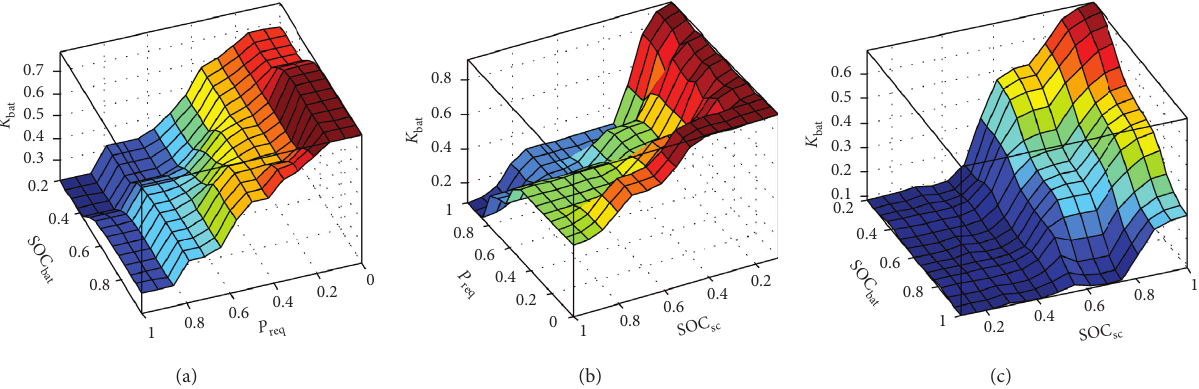
Figure 6: (a, b) Relation of inputs and output in discharge. (c) Relation of inputs and output in